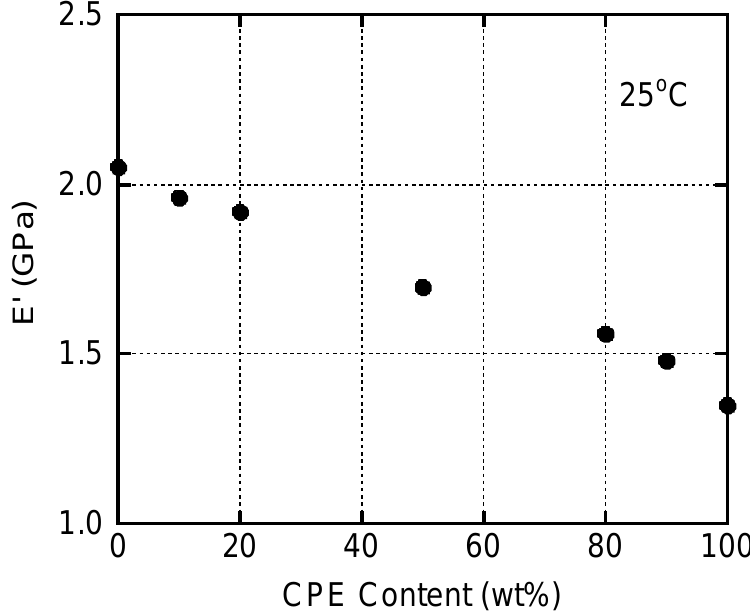
Figure 5. Relationship between E ′ at 25 °C and CPE content. The glass-to-rubber transition, i.e., α relaxation, was clearly detected for all sample films with a single sharp peak of E ″ , irrespective of the blend ratio. It is well known that the peak width represents the distribution of the relaxation time and, thus, becomes broad once the concentration fluctuation occurs in the system. Therefore, this result demonstrates that PC and CPE were miscible in the experimental blend ratios. In the high temperature range of the rheological transition region, the slope of the E ′ curves decreased again. For example, PC showed a different slope in E ′ at around 165 °C, and CPE had the same trend at 130 °C. This is reasonable because the rubbery region should be detected after the transition region. The E ′ values at the lowest temperature in the rubbery region seemed to slightly decrease with an increase in the CPE content, e.g., 10 MPa for pure PC and 5 MPa for pure CPE. This could be attributed to the low entanglement molecular weight M e of PC, which was reported to be 1330 – 1780 [44,45]. A low M e leads to a high rubbery plateau modulus G N 0 . Poly(ethylene terephthalate) is also known to have a low M e (1170 – 1450) [44,45]. Although CPE contains ethylene terephthalate unit, the diol com- ponents must give a high M e of CPE as compared with PC. In fact, Asai et al. revealed that a polyester comprising 1,4-cyclohexanedimethanol has a high M e [46]. The peak temperature of α relaxation was assigned as the glass transition tempera- ture T g in this study and plotted against the CPE content in Figure 6. The line in the figure represents the predicted values calculated from the Fox equation [47].